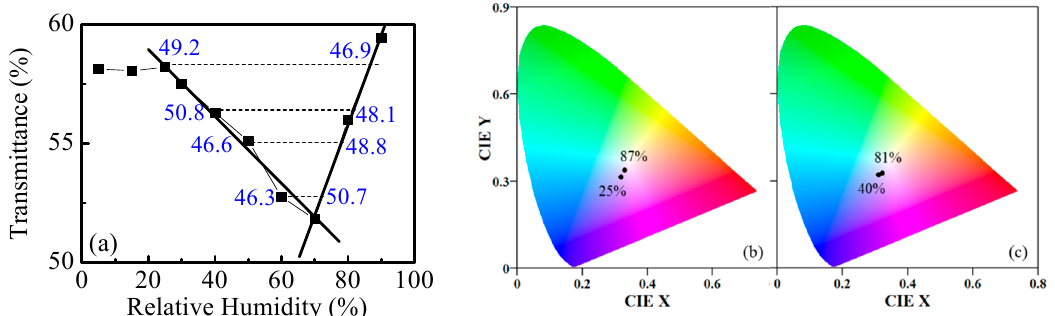
Figure 10. Humidity dependence of transmittance values at λ max = 700 nm ( a ) and calculated CIE color coordinates ( b , c ) of polymer (300 nm) / Au–Pd film (30 nm) / glass exposed to denoted levels of relative humidity. The blue numbers denote transmittance values measured at a wavelength of 430 nm.